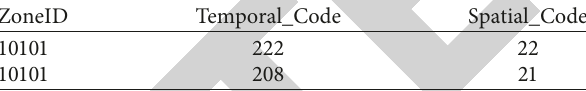
Table 2: Spatiotemporal mobility pattern